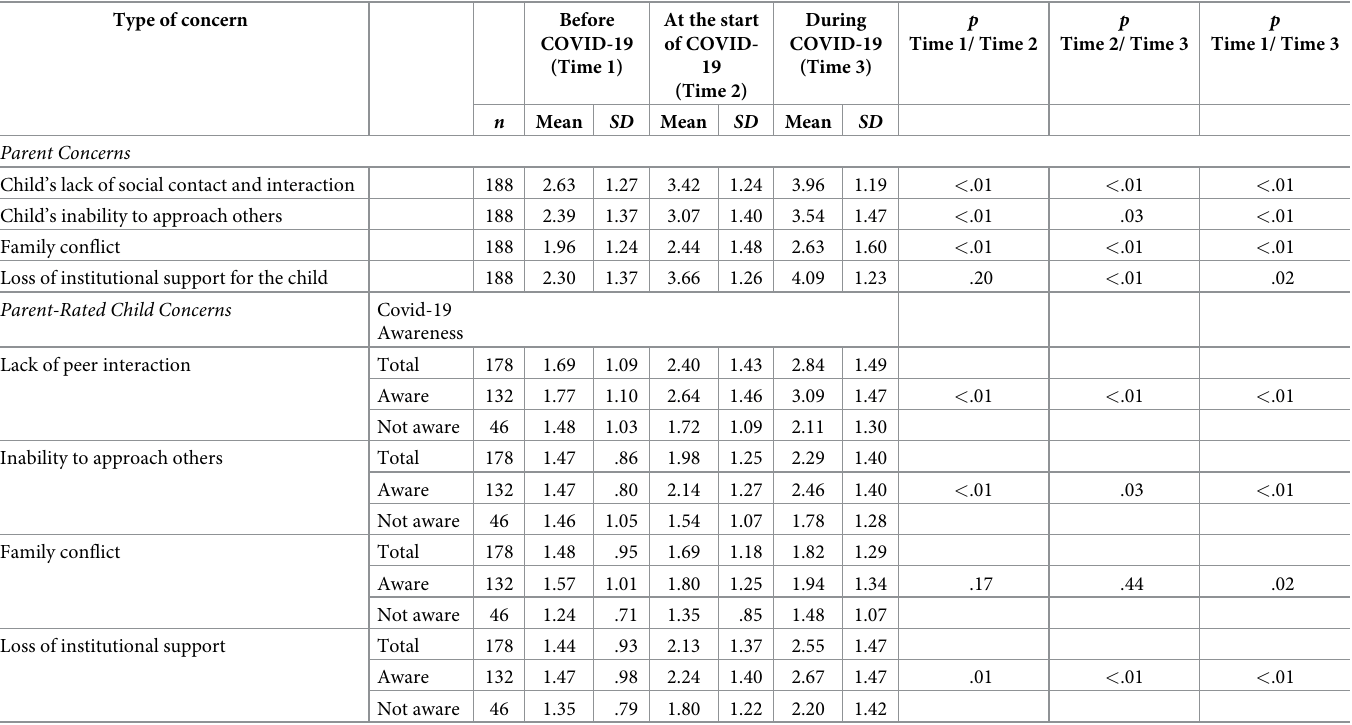
Table 2. Descriptive statistics of parent concern ratings and parent-rated child concern ratings at each time